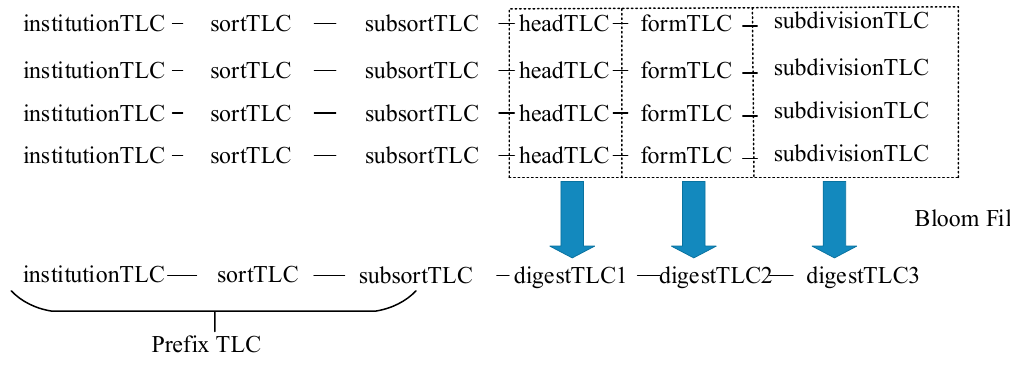
Figure 2. Generation of aggregate object identifiers (OID).